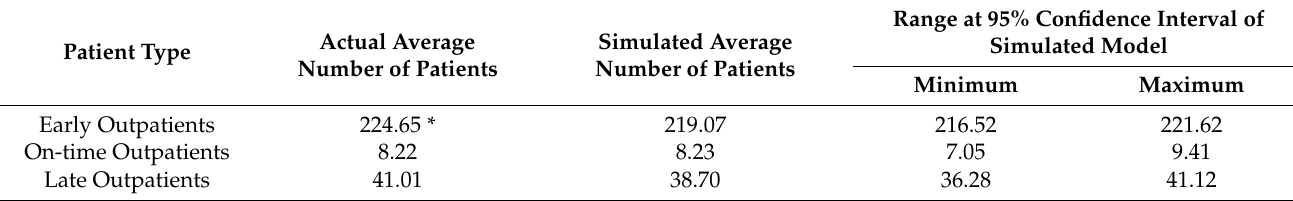
Table 6. Outpatient actual average number of arrivals and simulated average number of arrivals in 5 days.